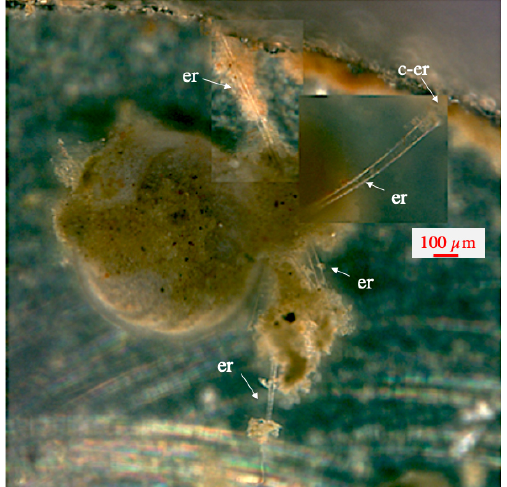
Figure 3. Ectoplasmic roots of C. wuellerstorfi . Starting with the lower ones, ectoplasmic roots were developed over a period of 1 week and remained unchanged for the remaining 5 weeks of the experiment. “er” denotes ectoplasmic root; “c-er” denotes contact zone of ectoplasmic root with the aquarium glass. Figure 4. Ectoplasmic roots of C. lobatulus . (a) Cibicidoides lobat-